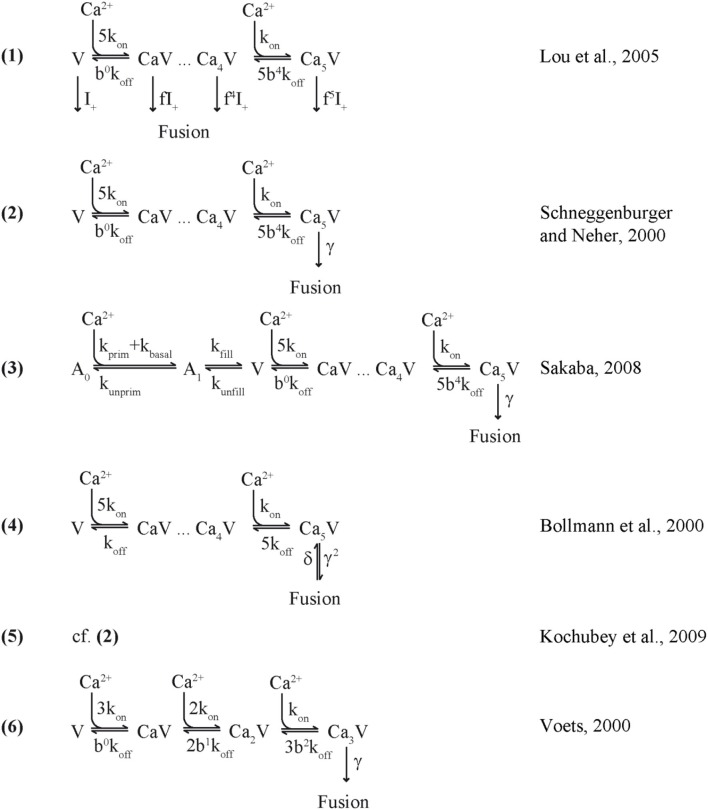
Release sensor models.